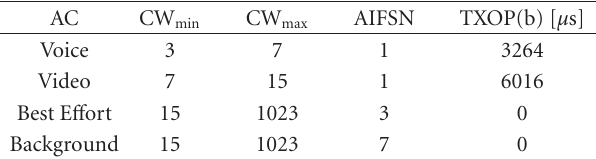
Table 1: EDCA parameters used for